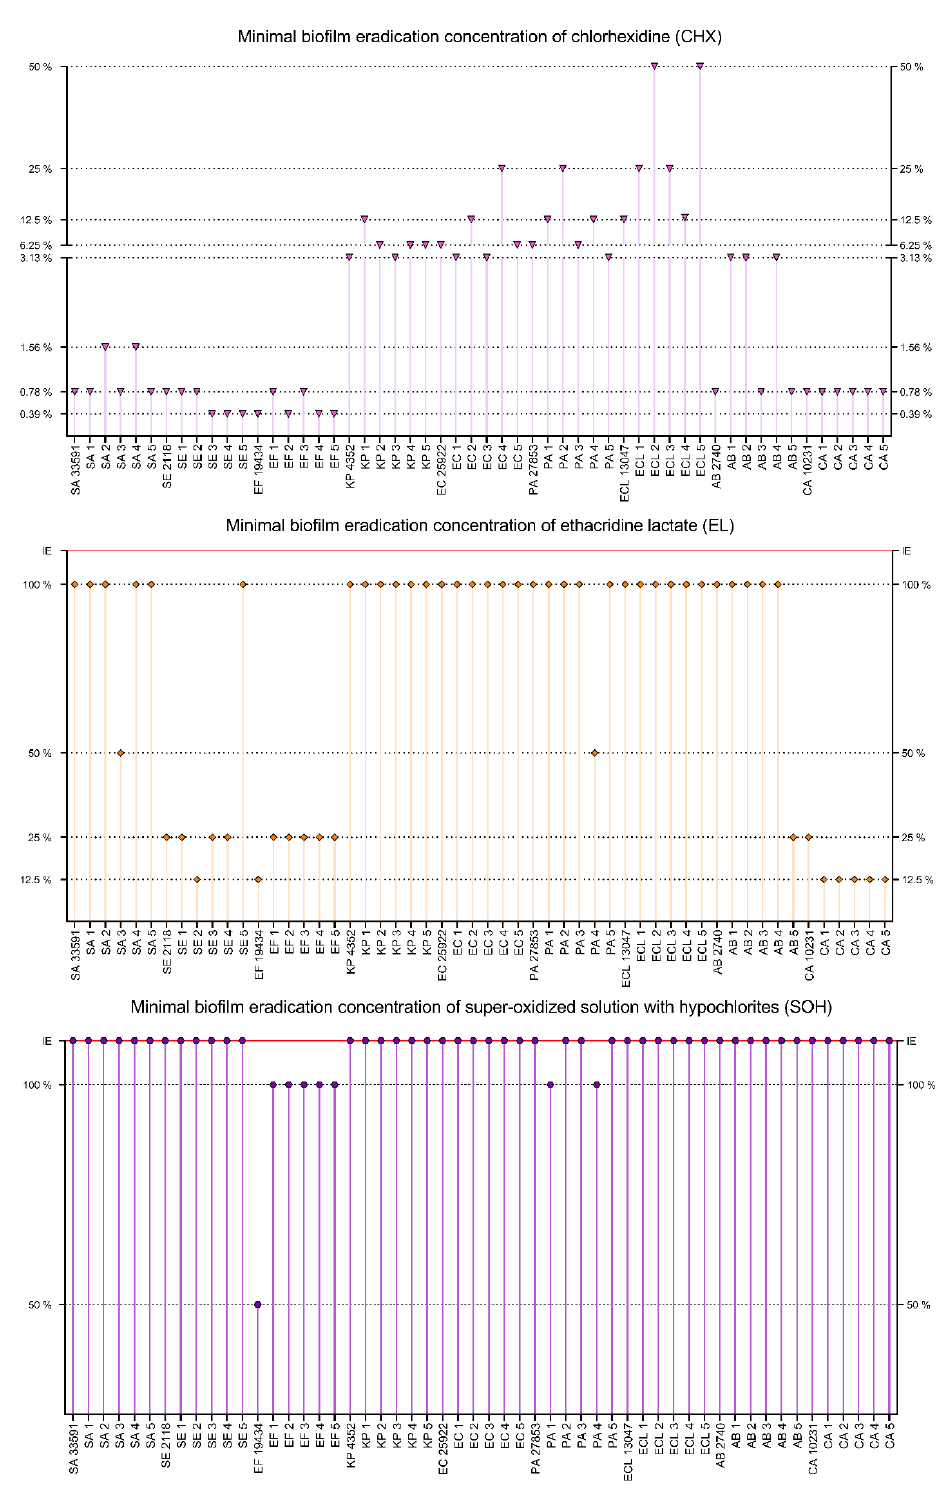
Figure 9. Minimal biofilm eradication concentrations of OCT, PHMB and PVP-I, presented as a percentage of working solutions (concentration provided by the manufacturer). Tested compounds: CHX — chlorhexidine, EL — ethacridine lactate, SOH — super-oxidized hypochlorites solution (water solution of chlorhexidine diluted to 0.5% of CHX, Rivanol ® 0.1% of EL and Microdacyn ® 0.004% + 0.004% of NaOCl and HOCl). Tested strains: SA — Staphylococcus aureus , SE — Staphylococ-